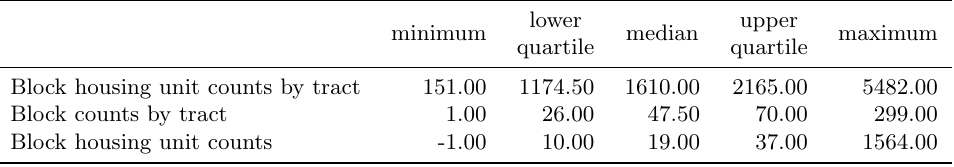
lower upper minimum median maximum quartile quartile